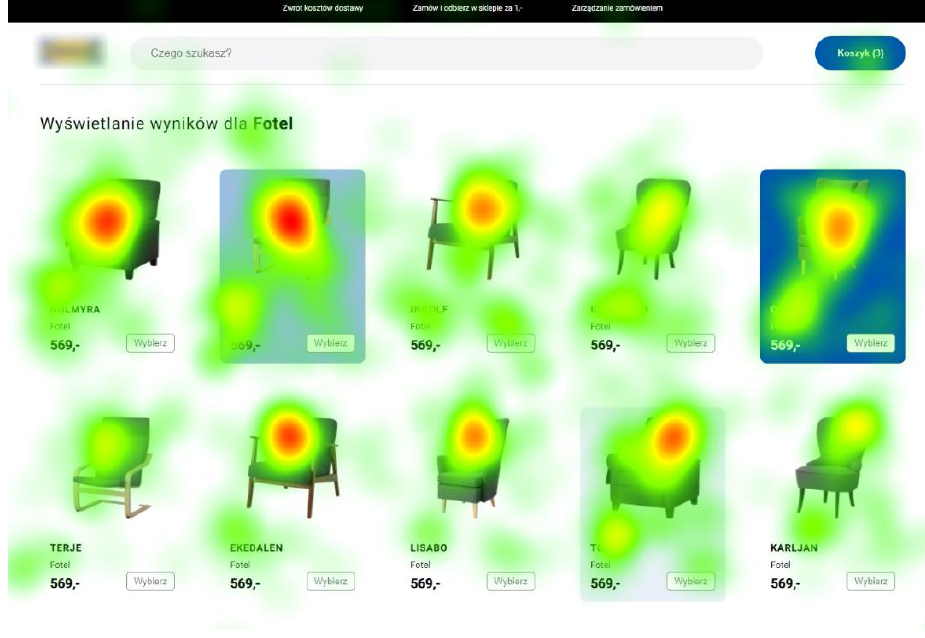
Figure 7. Heatmap for the second product category with background highlights. Source: own elab- oration.